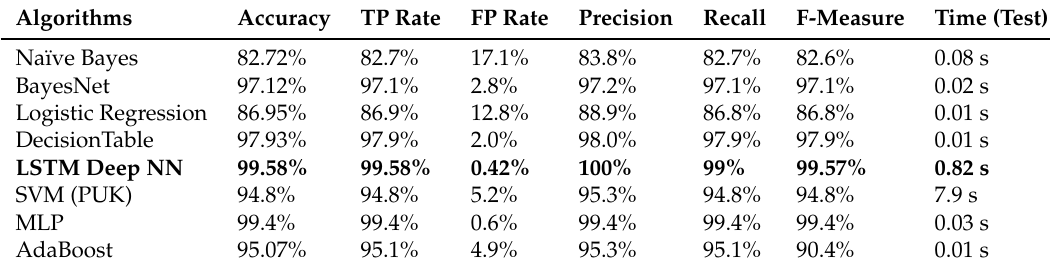
Table 5. Performance evaluation for attack scenario 2.